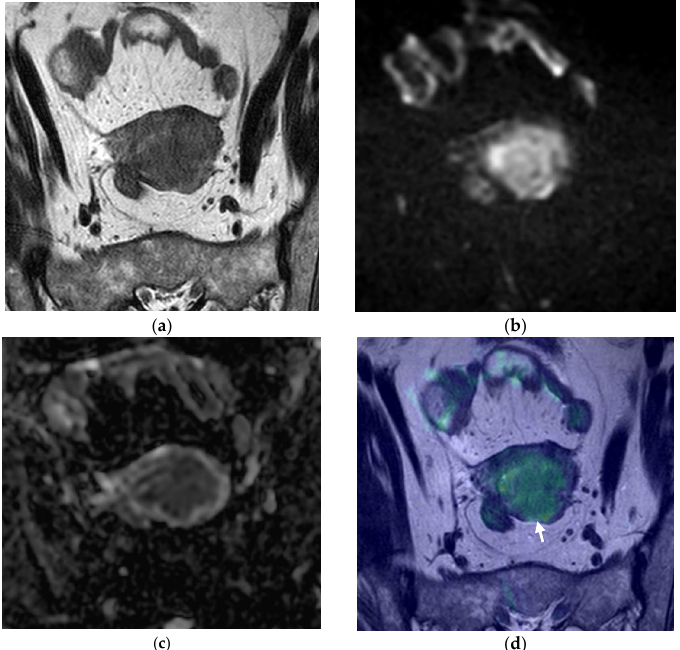
Figure 1. Pelvic MRI, axial oblique sequences oriented to the corpus uteri long axis: ( a ) T2WI; ( b ) DWI (b1000); ( c ) ADC map; ( d ) fused T2WI-DWI image. In ( a ), the endometrial cancer is hardly perceptible, being more depictable in functional images ( b , c ). It is difficult to establish if there is deep myometrial invasion using just the standard MRI sequences, but in analyzing the fusion image ( d ), it is clear that there is extension to the deep myometrial (arrow), which was confirmed with histopathological analysis.